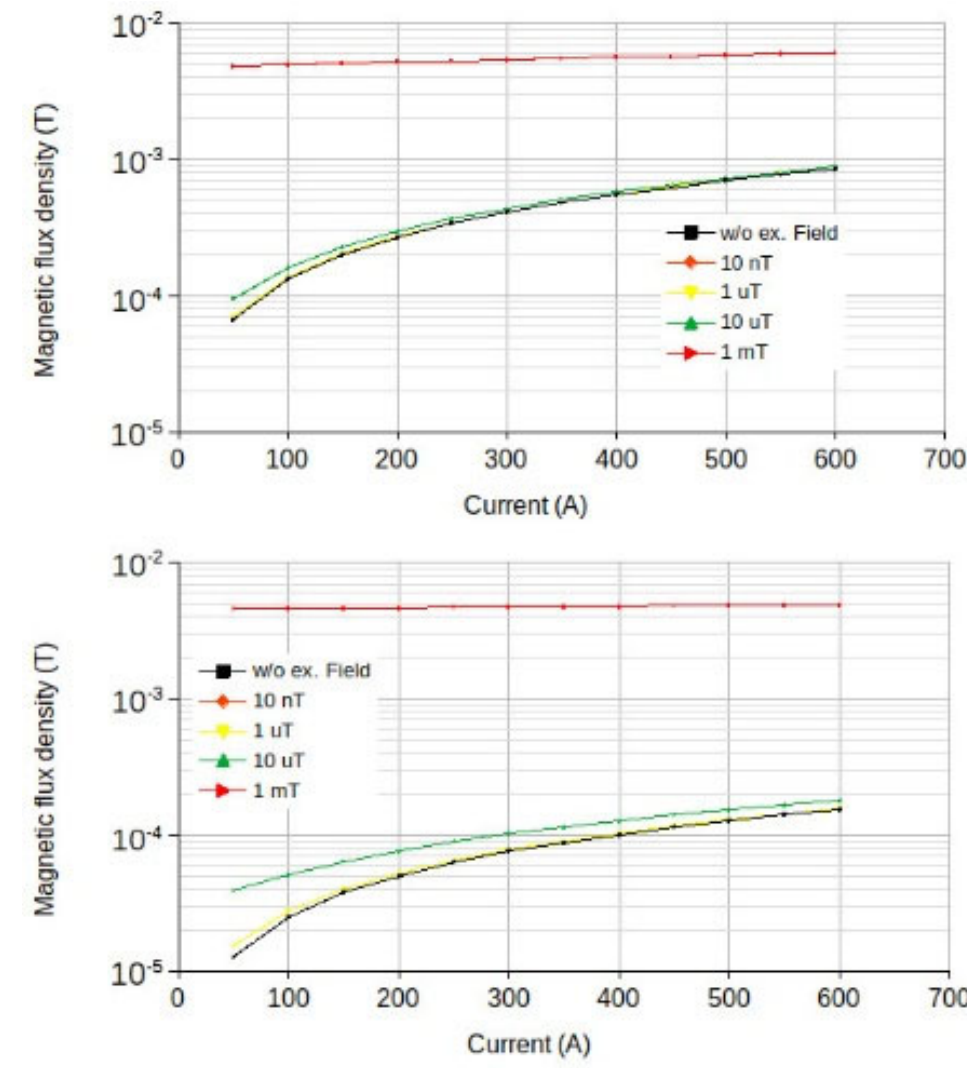
Figure 5. The dependence of the values of the magnetic field vector Z-component in the core of the ferroprobe on the current value in the cable for various values of the external magnetic field induction. Upper panel—distance 1 m between the microtunneling shield and the cable, lower panel—distance 3 m. The results show the possibility of registering the Y- and Z-components of the electro- magnetic field of an energized power cable by ferroprobes in the body of a microtunneling shield at an external magnetic field induction of up to mT-sized